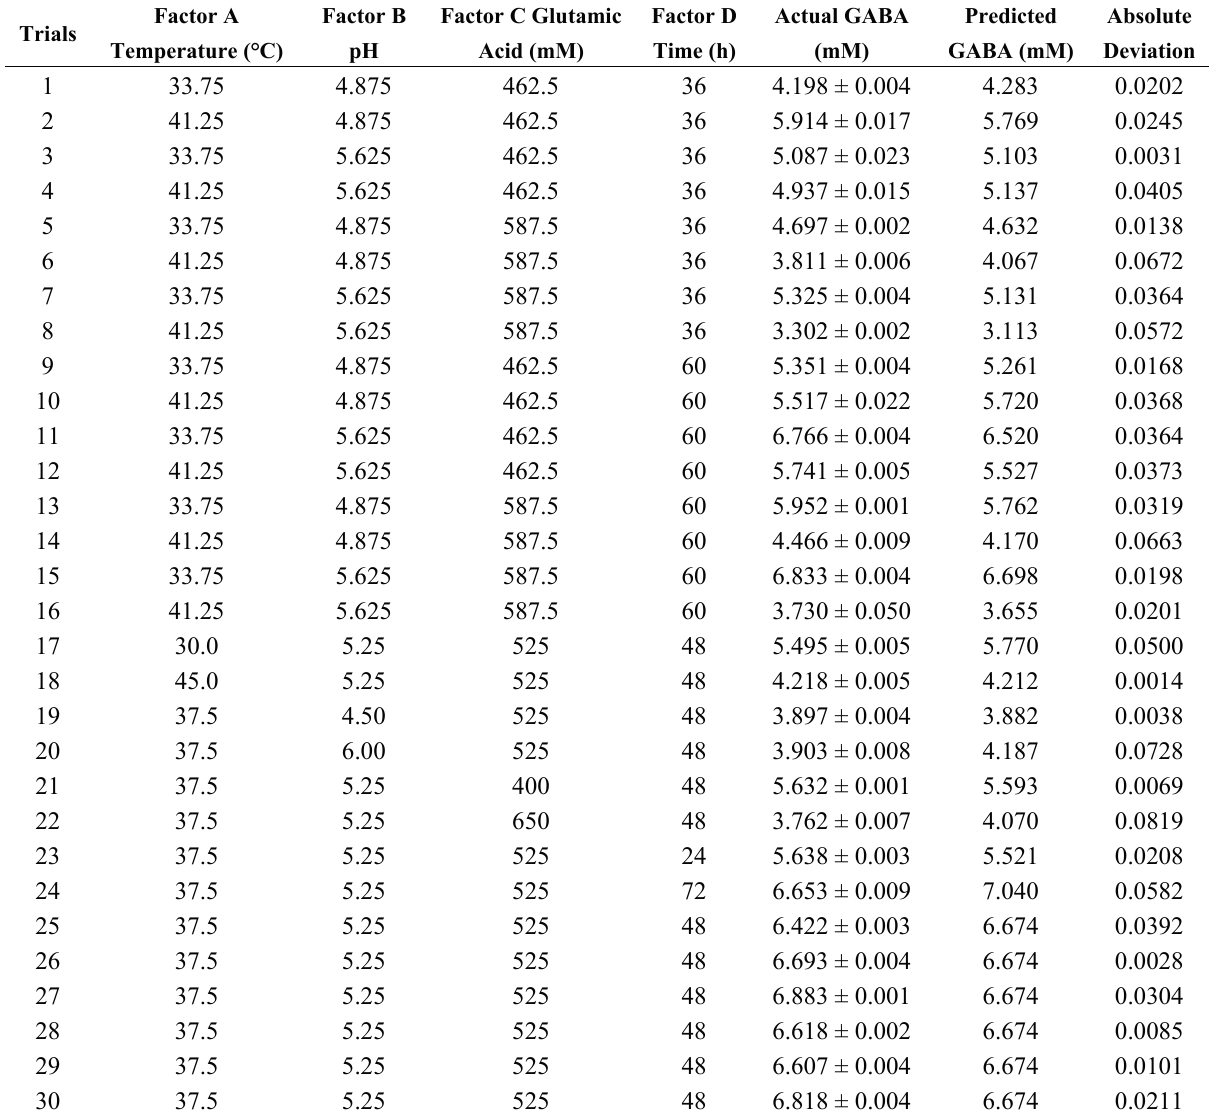
Table 1. Lactobacillus plantarum Taj-Apis362 treatment incorporations and